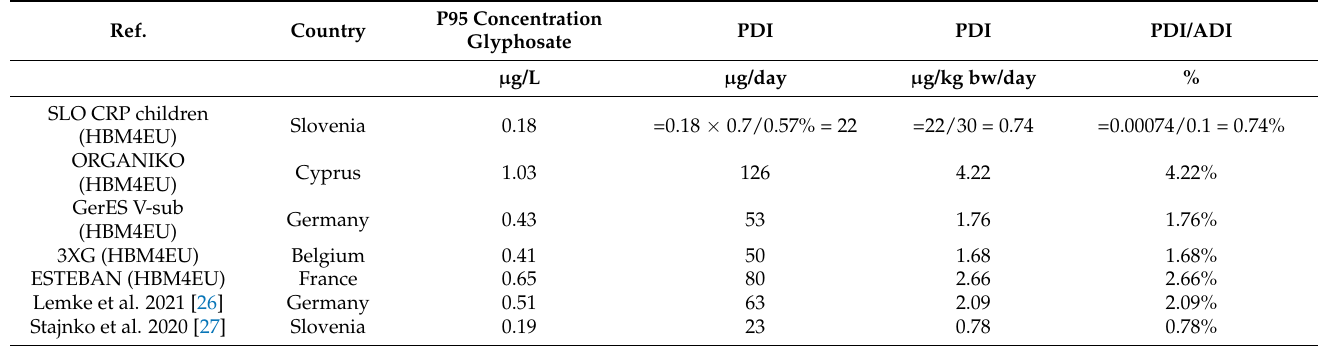
Table 4. Risk assessment of glyphosate based on HBM data (detection of Gly and AMPA with mass